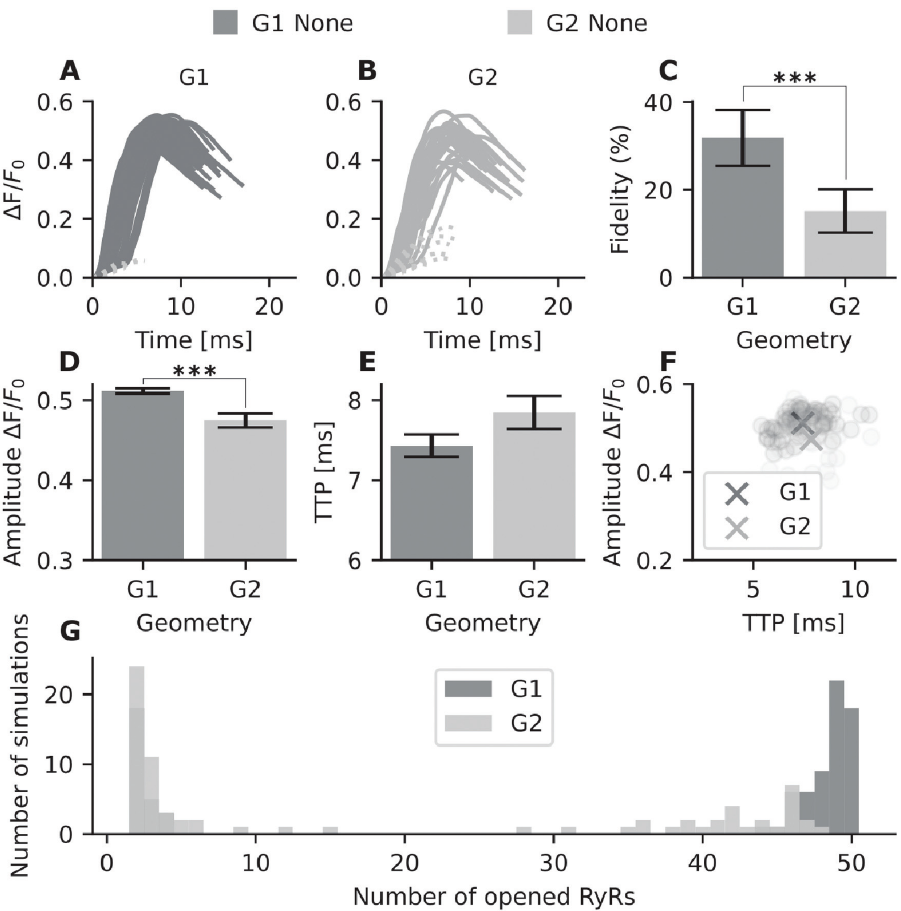
Fig 4. Spark properties of unphosphorylated RyR in geometries G1 and G2. For each geometry 200 simulations were conducted. (A) Intensity over time for G1 calcium sparks. Dark gray: successful sparks (n = 63), light dotted gray lines: failed sparks. (B) Intensity over time for G2 calcium sparks. Gray: successful sparks (n = 29), light dotted gray lines: failed sparks. (C) The probability of spark generation (spark fidelity) for G1 and G2. Error bars indicate the 95% Agresti-Coull confidence interval. (D) Spark amplitude (mean ± standard error) for successful sparks in G1 and G2. (E) Average time to peak (TTP) (mean ± standard error) for G1 and G2, in ms. (F) Scatter plot of spark amplitude versus TTP. The crosses represent the mean values across all simulations for G1 and G2. (G) Histogram tracking total number of opened RyRs across individual simulations for G1 and G2. For example, for geometry G1 all 50 RyRs are opened in 18 simulations, whereas for G2 no simulations had 50 open RyRs. ��� =p < 0.001. The p values were calculated from a t-test, except for the fidelity p value which was calculated from Fisher’s exact test (due to binary